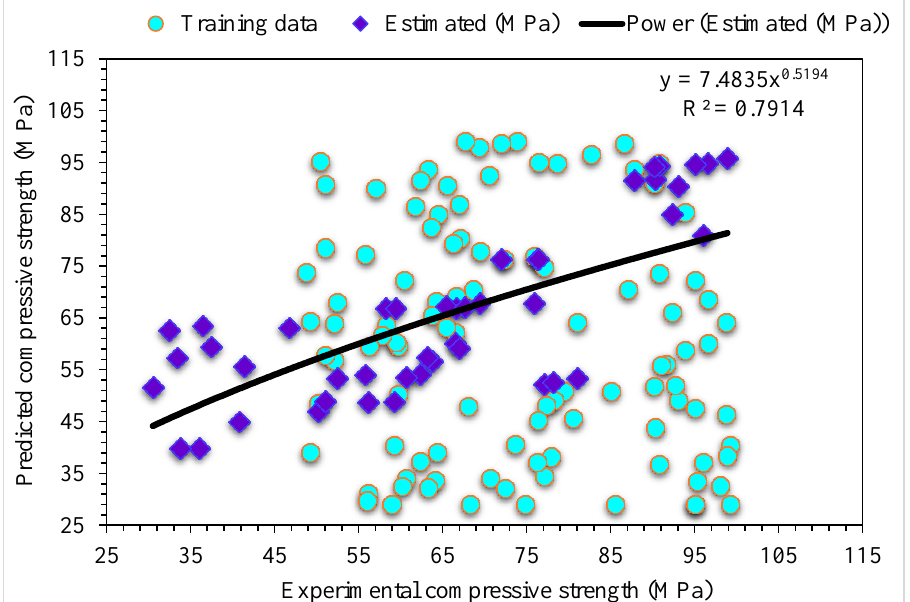
Figure 4. Experimental and MLPNN predicted results for compressive strength.